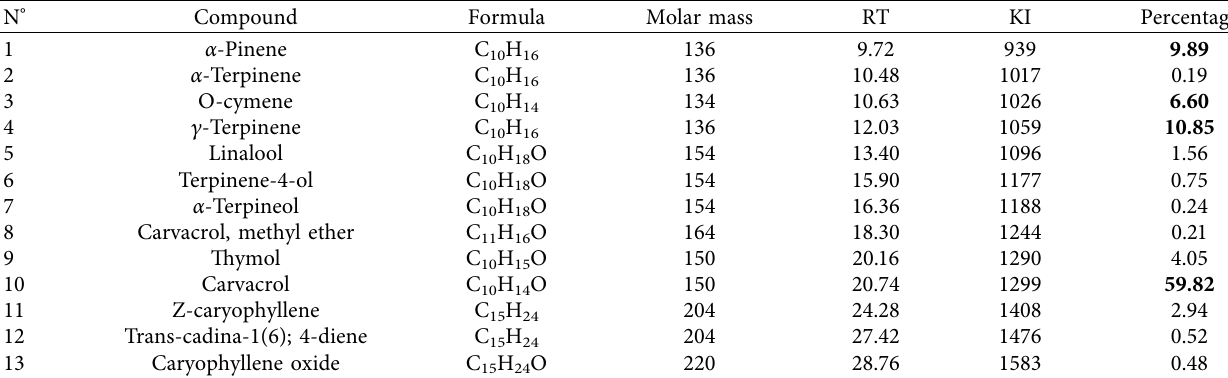
Table 2: Chemical composition of commercial oregano EO.